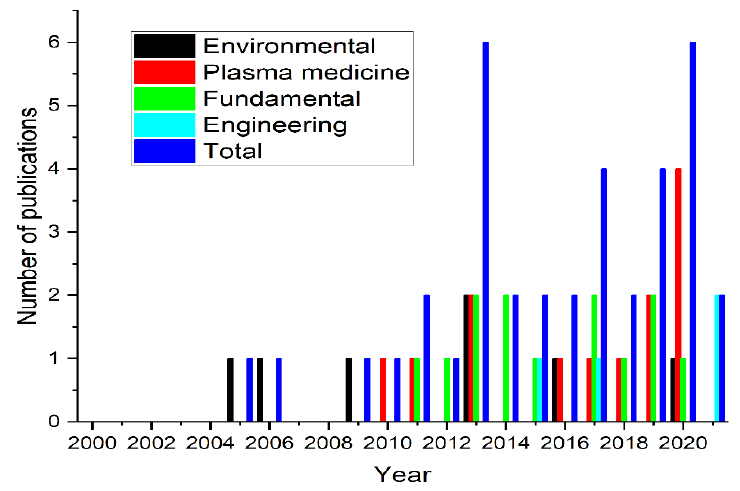
Figure 3. Distribution of published studies by year and macro research field.